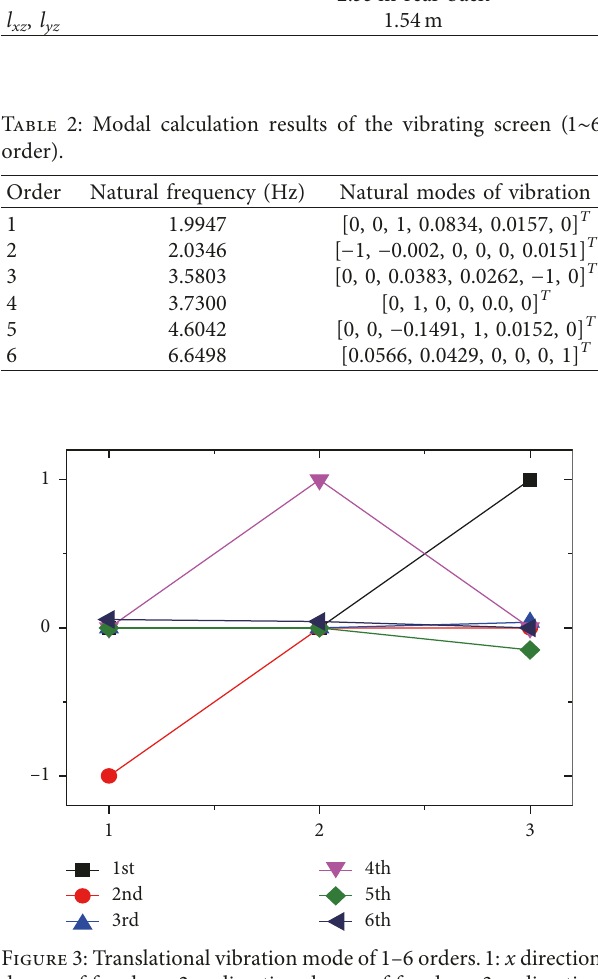
Figure 3: Translational vibration mode of 1–6 orders.1: x direction degree of freedom; 2: y direction degree of freedom; 3: z direction degree of freedom.